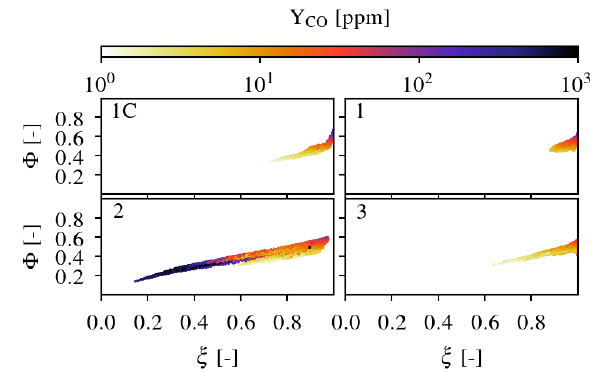
Figure 12. Equivalence ratio over primary air ratio ξ in dependency of CO for the different cases at the combustor outlet